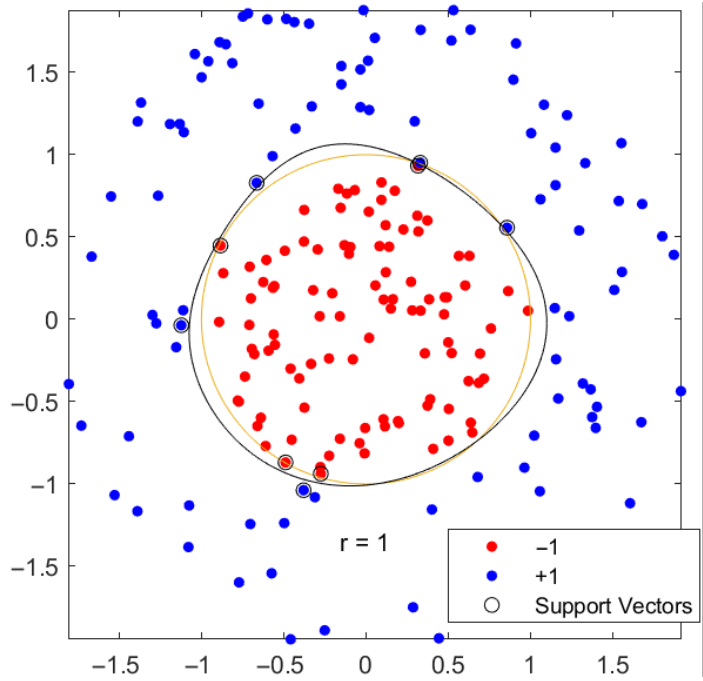
Figure 7. SVM classification using a nonlinear hyperplane and the classification result and the used support vectors to create the hyperplane.